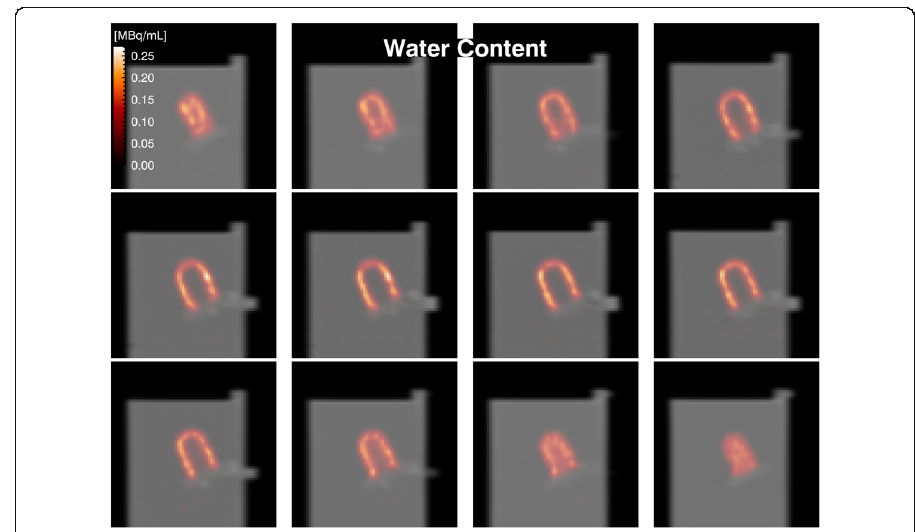
Fig. 7 Twelve consecutive SPECT slices (50 iterations) overlaid on the corresponding CT slices for a cardiac insert in a water-filled torso. The ventricle cavity was filled with water. The MCR and CT results are well registered with good contrast between the myocardium and ventricle. Despite the attenuation in the cavity water, the homogeneity of the activity in the myocardium is well recovered, albeit somewhat nosier than in Fig. 7, due to the modelling of attenuation in the